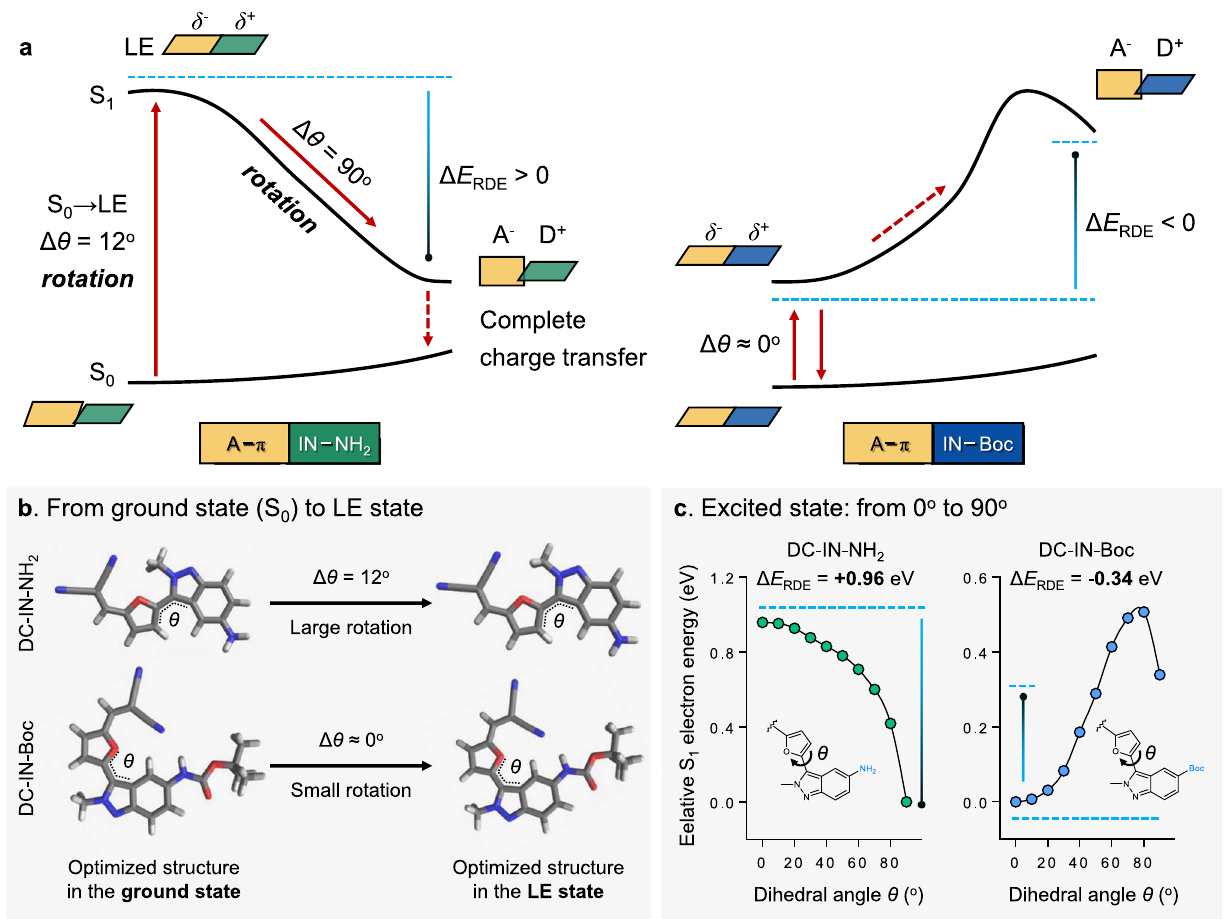
Fig. 4 Quantum chemical calculations for elucidating the key role of intramolecular rotation in the fl uorescence umpolung mechanism. a Jablonski diagram illustrating the distinctly different photoexcitation and deactivation processes of DC-IN-NH 2 and DC-IN-Boc. b Optimized molecular structures of DC-IN-NH 2 and DC-IN-Boc in the ground state and the locally excited (LE) state. c Calculated S 1 PESs (potential energy surfaces) for DC-IN-NH 2 and DC- IN-Boc. The theoretical model of describing the LE state (partial charge transfer) → circa 90° twisted excited state (complete charge transfer) photoreaction by plotting S 1 PES along the rotation angle ( θ ). Source data are provided as a Source Data fi le. We show that the electron density perturbation of indazole can lead to a mutational effect on intramolecular rotation driving energy ( Δ E RDE ), fl ipping between positive (enhance rotation) and negative (suppress rotation). Δ E RDE = E (0°) − E (90°) (i.e., energy difference between 0° excited state and 90° twisted excited state in the S 1